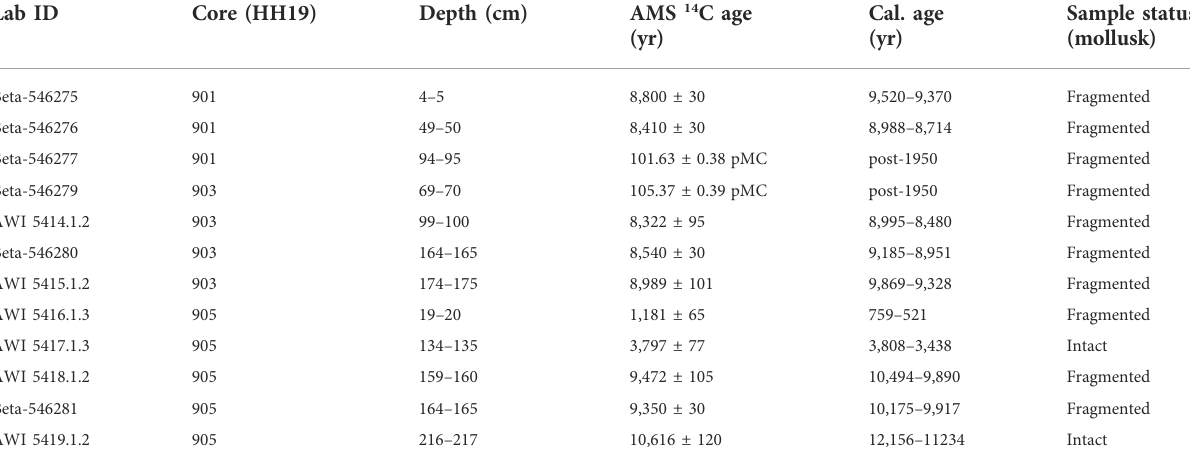
TABLE 1 AMS 14 C dates and calibrated dates for the studied